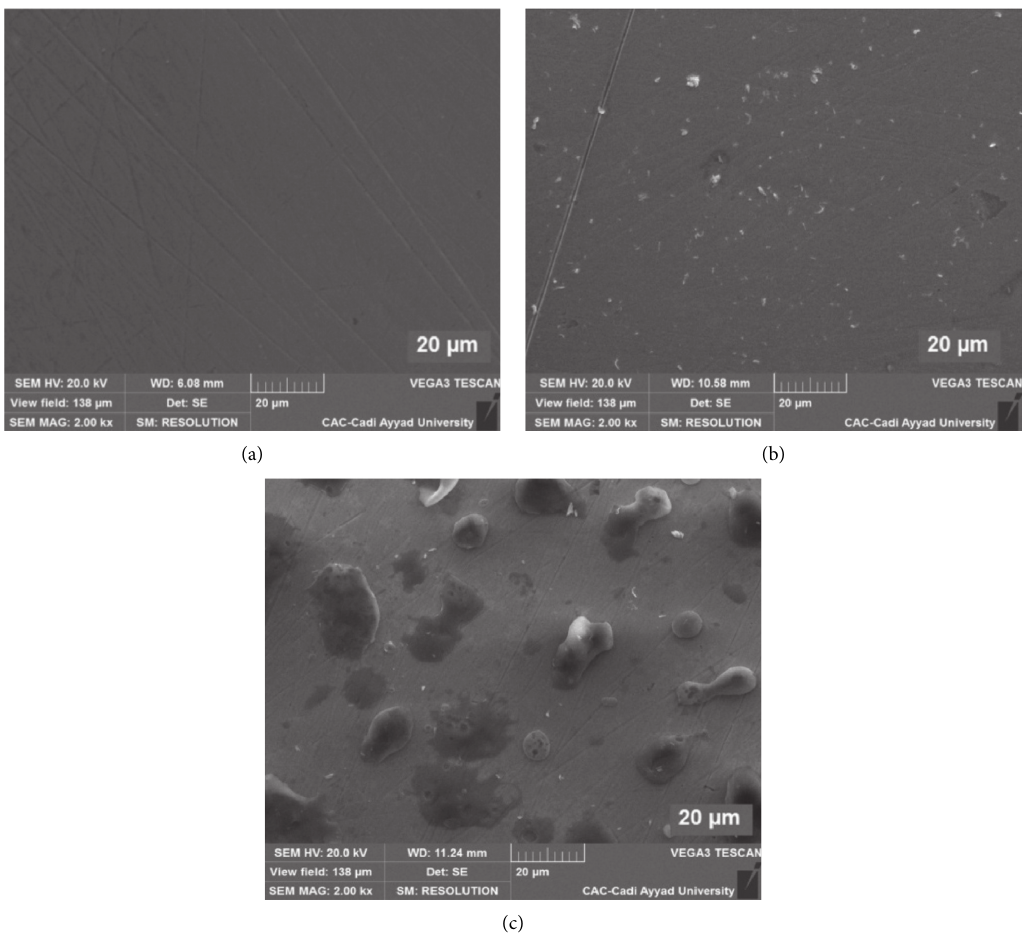
Figure 7: SEM micrographs of (a) freshly polished SS specimen, (b) SS specimen exposed to 1M H H 2 SO 4 containing 10 − 3 M of